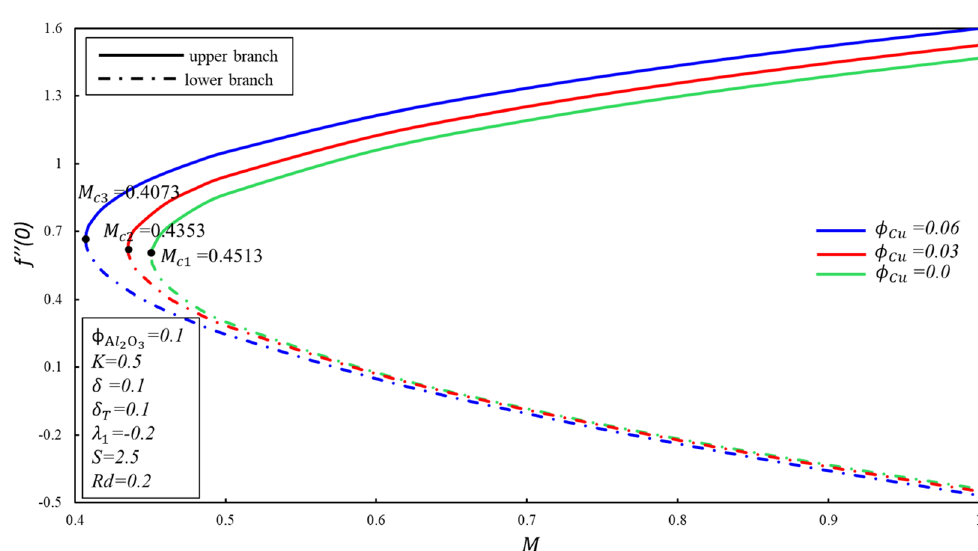
θ ′ ( 0 ) in impact of δ T . −